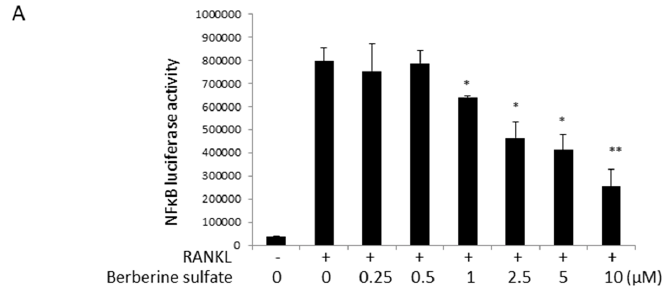
Figure 4. Cont. Figure 4. Cont .